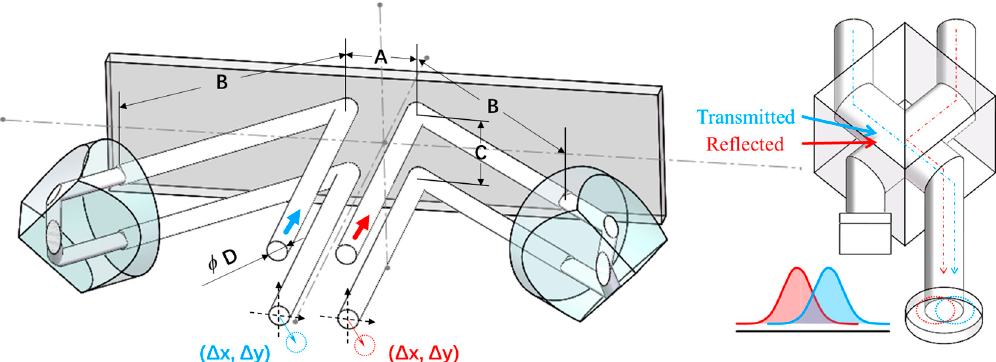
Figure 6. Mathematical model and the crucial structural parameters of the spatially separated heterodyne grating interferometer and the interfering intensity of the Gaussian beams.